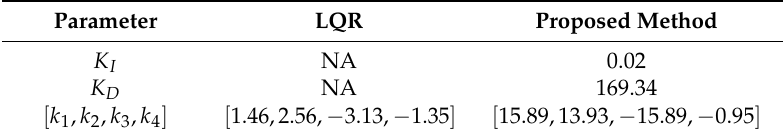
Table 4. Parameters of the linear quadratic regulator (LQR), and the proposed